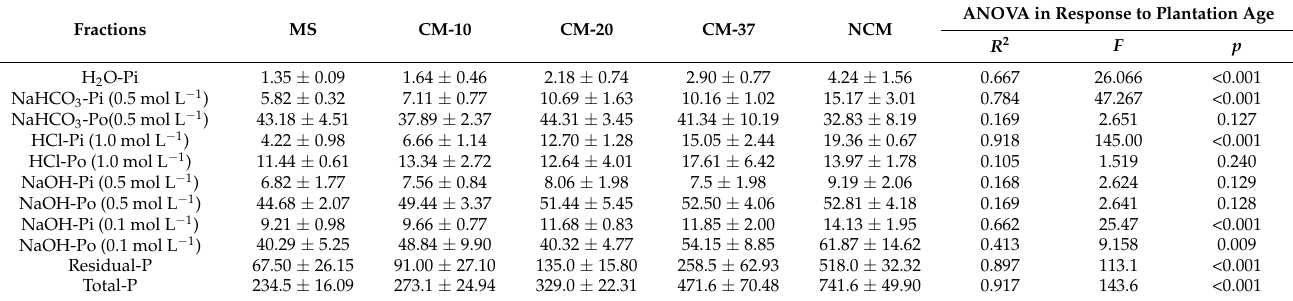
Figure 2. Responses of soil properties to plantation development. Table 1. Fractions of soil P at different Caragana microphylla plantations (mg kg − 1